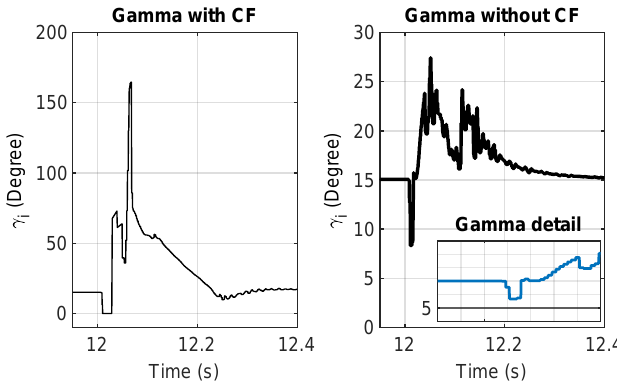
Figure 4. Graphic representation γ i dynamics following AC